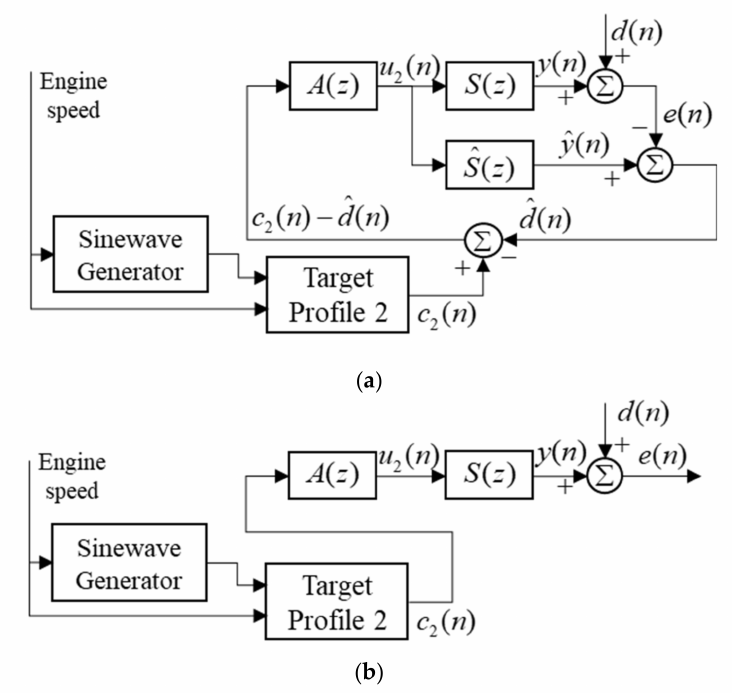
Figure 4. ( a ) Feedback ASP algorithm with the IMC structure and ( b ) its simplified version as a purely feedforward